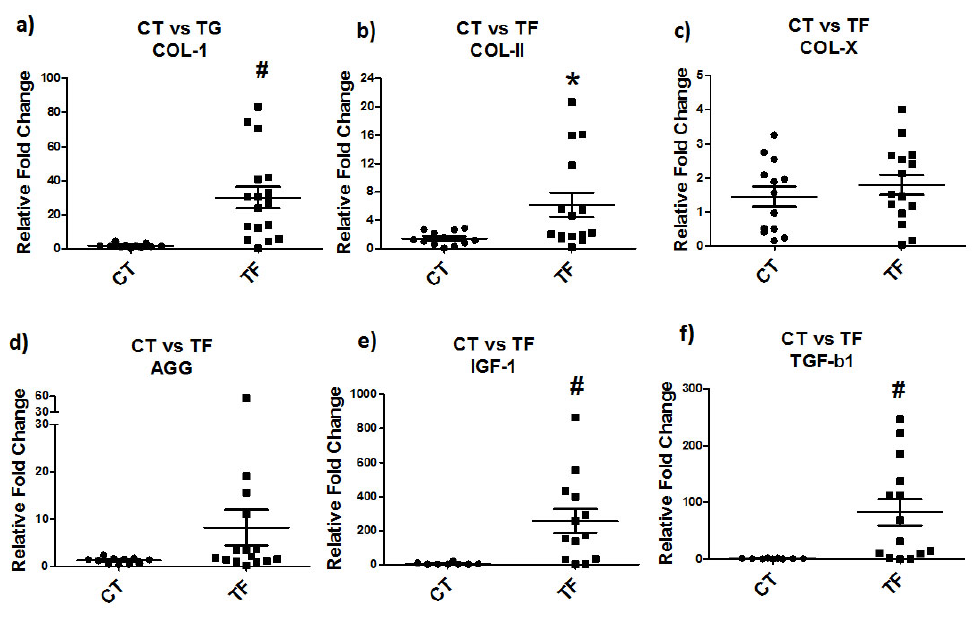
Figure 1: Extracellular matrix and growth factors genes dysregulated in trigger finger samples. ( a ) Collagen1, ( b ) Collagen 2, ( c ) Collagen X, ( d ) Aggrecan, ( e ) IGF1 and ( f ) TGFb1 gene expression level dysregulated in trigger finger (TF) samples compare to Carpel tunnel syndrome (CT). *P<.05, #P<.01, (n=8-17).